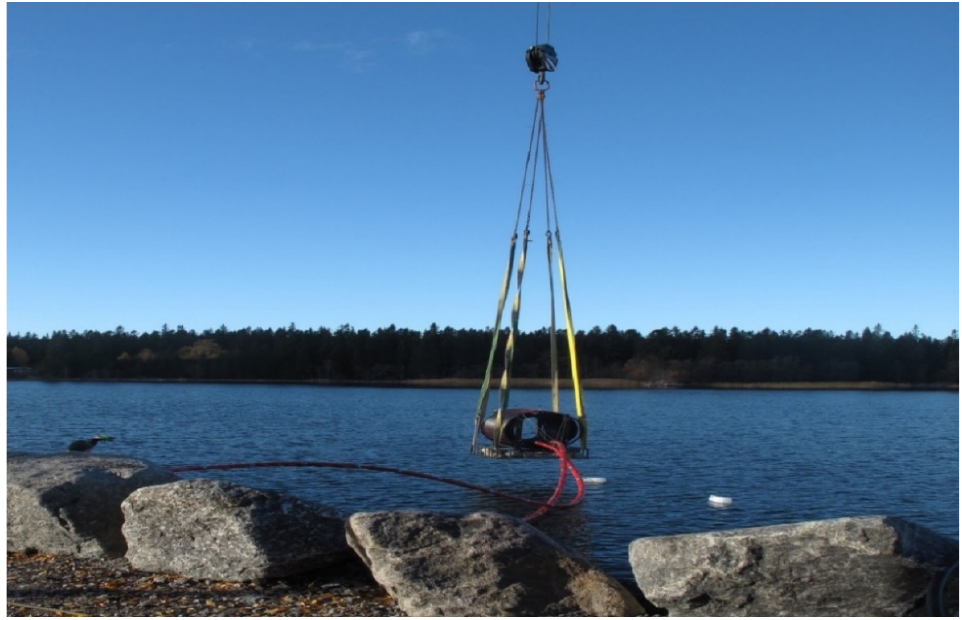
Figure 4. The water heat exchanger being put inside the sea shore at Merten Talo (Picture taken by Anne Mäkiranta during installation process 18 October 2018). Table 1. Shows a potential supplier of the GeoPipe water heat exchanger product list